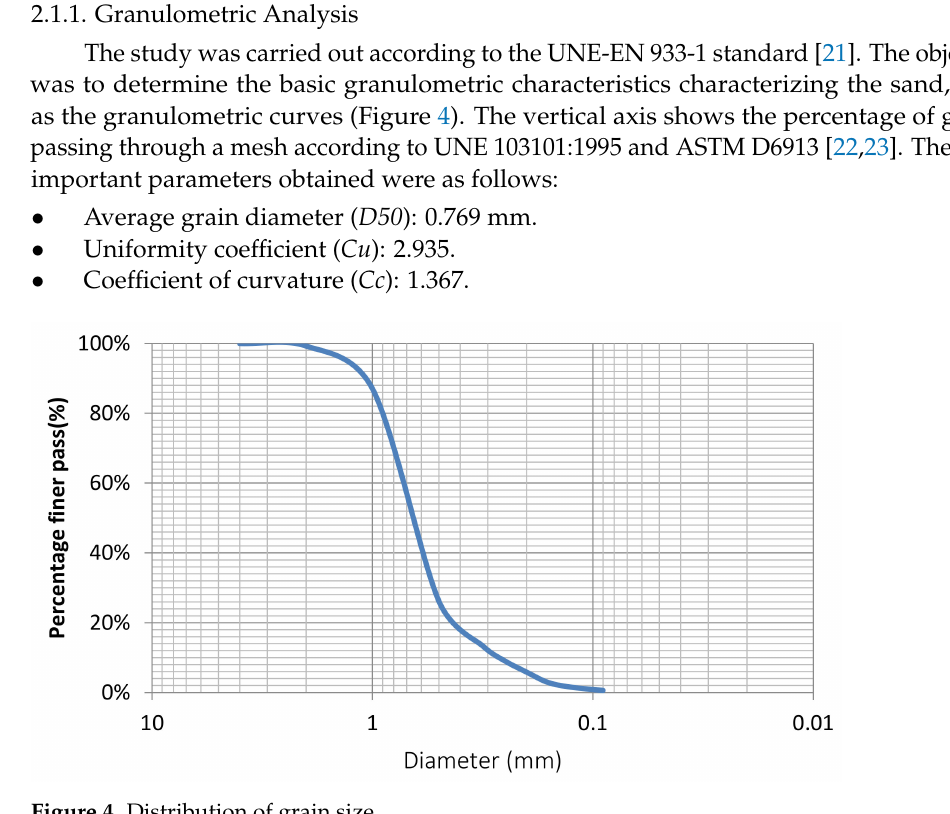
Figure 4. Distribution of grain size.